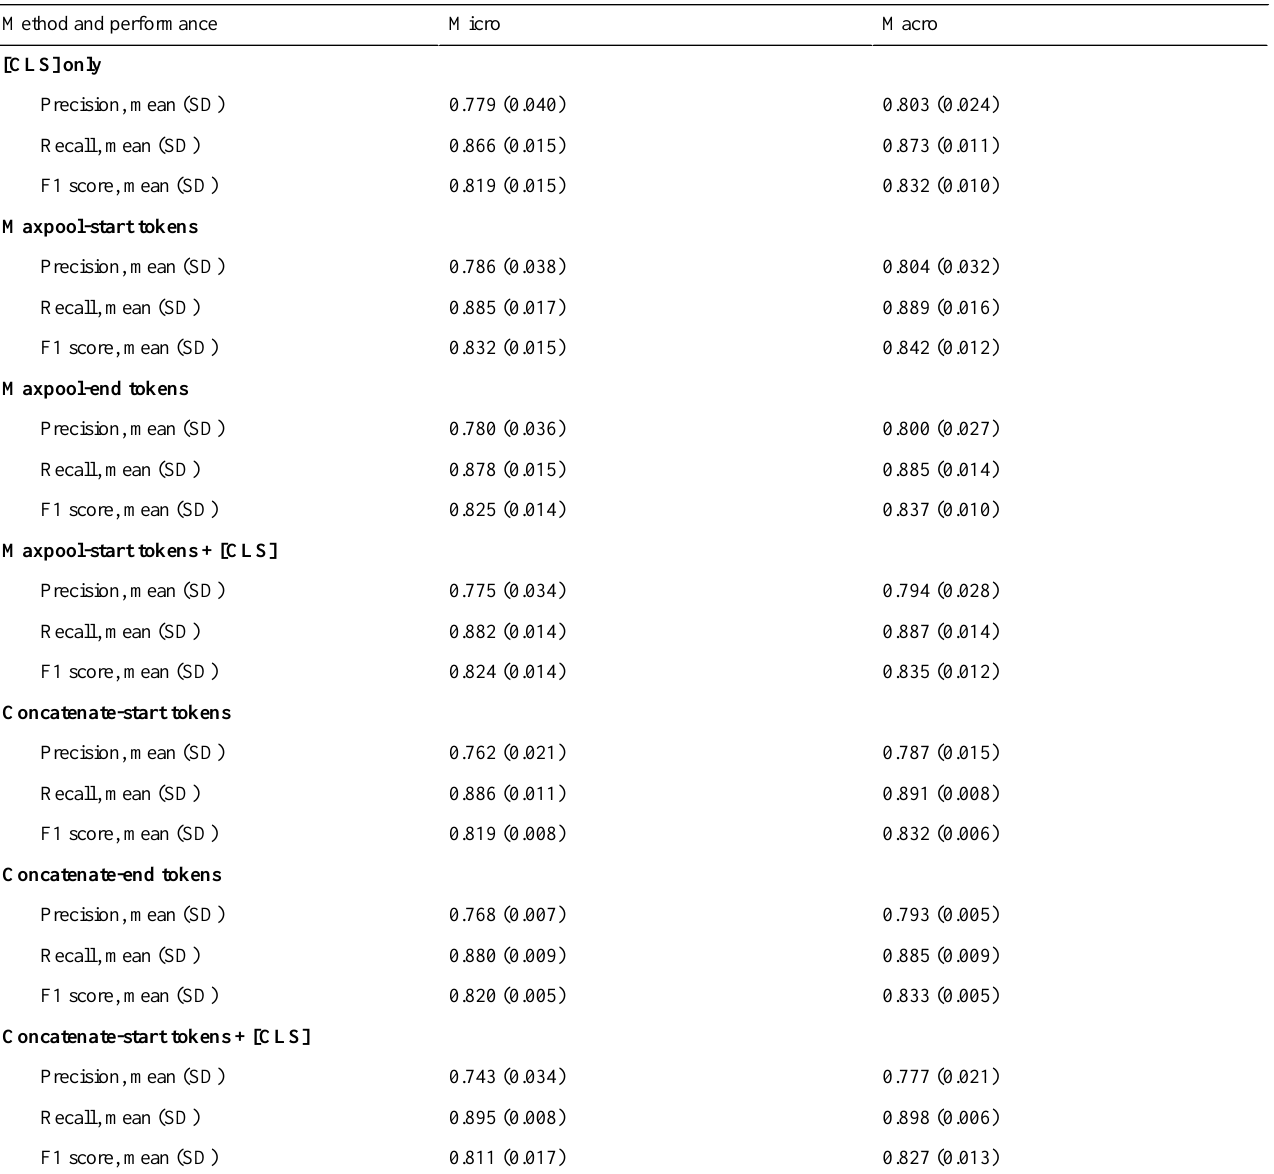
Table 4. Effect of different sequence representation methods on the BioBERT (BERT pretrained on biomedical data) model. MacroMicroMethod and